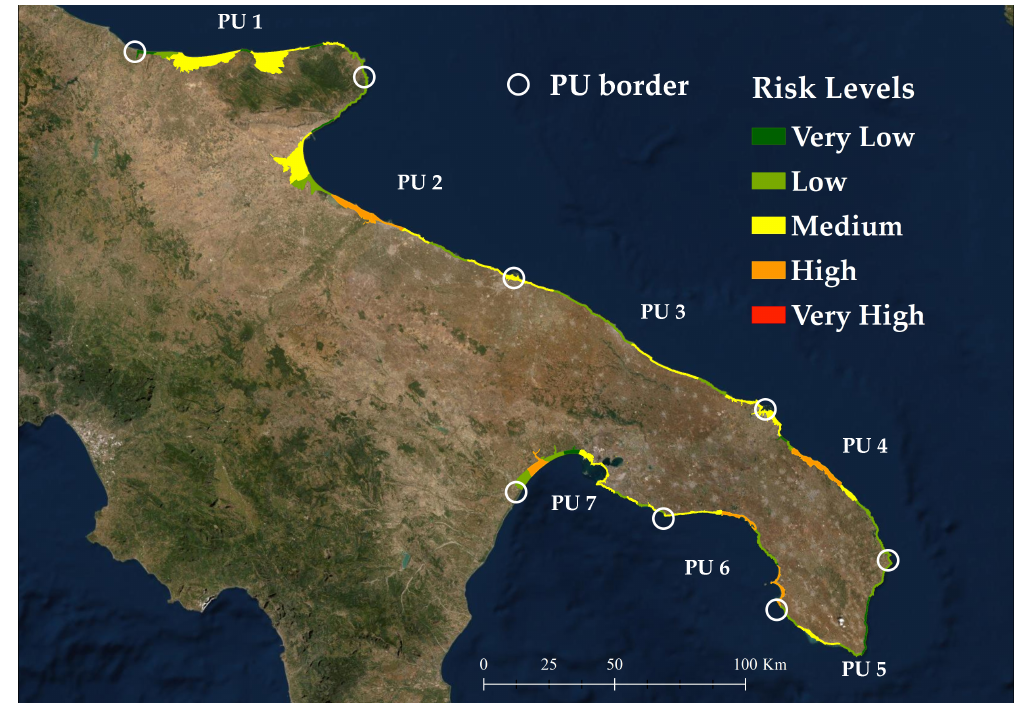
Figure 7. Normalized Coastal Risk Levels estimated using the modified EUrosion model: Scenario IPCC RCP4.5. The satellite image is from GoogleEarth.